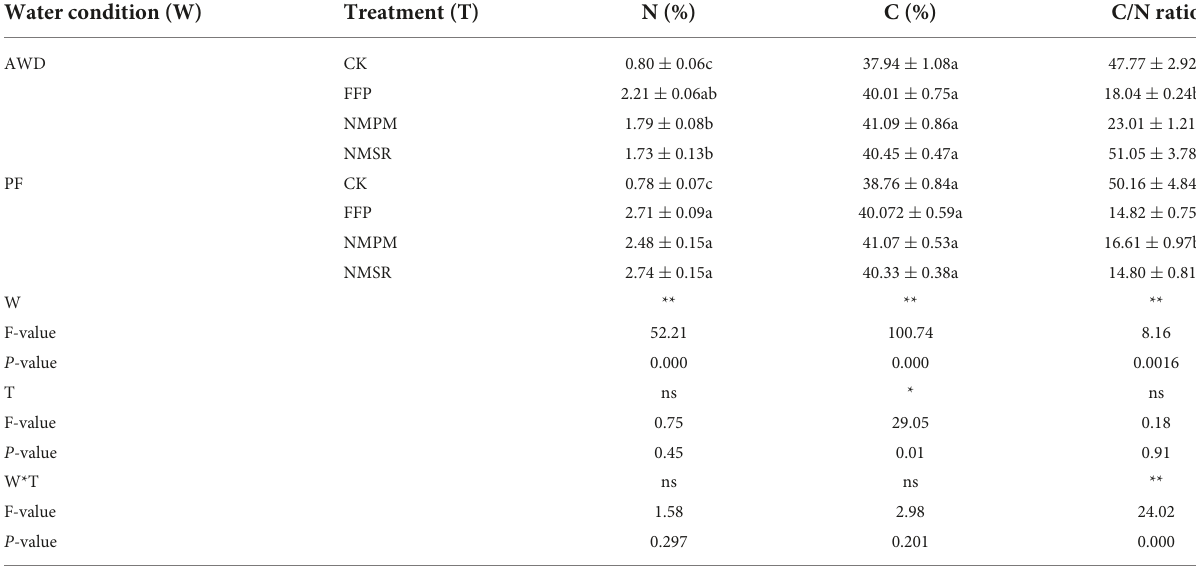
TABLE 2 Combined effects of different fertilizer treatments during alternate wetting and drying (AWD) and permanent flooding (PF) on inorganic nutrients in shoot. Water condition